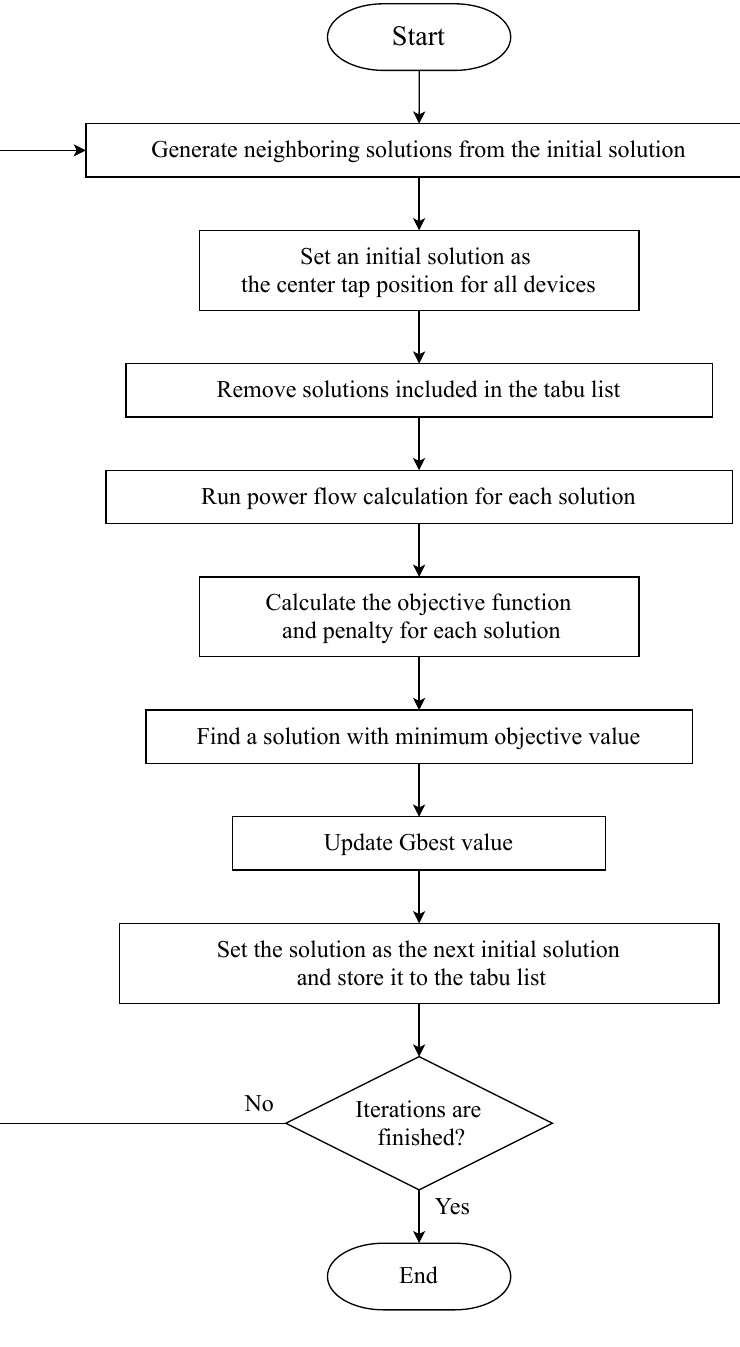
Figure 1. Flowchart of the applied tabu